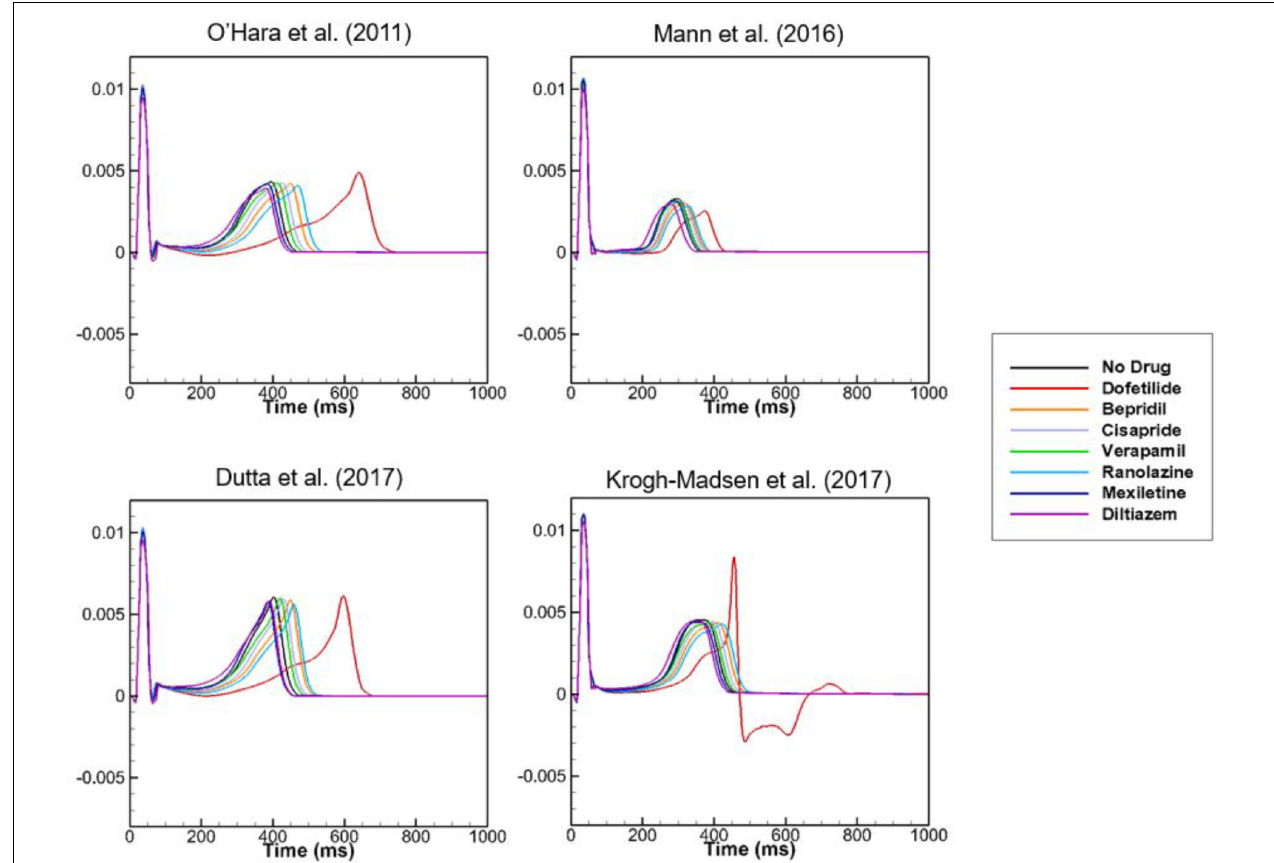
FIGURE 5 | ECGs with different cell models. Body-surface ECGs (lead I) are shown for 7 drugs applying different cell models at 1 × Cmax. Irregular morphology of ECG is observed for dofetilide in the case of the model by Krogh-Madsen et al. (2017).